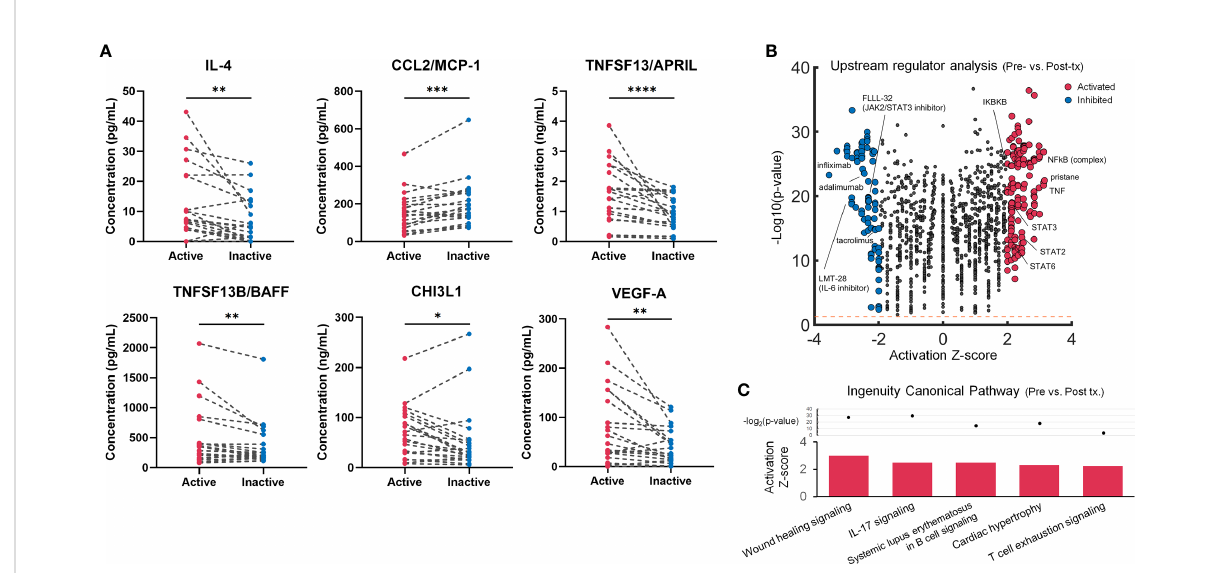
FIGURE 1 Multiplex blood cytokine/chemokine analysis results in the untreated and treated patients with large-vessel vasculitis (LVV). (A) Twenty-one blood samples from 21 patients with LVV in active or inactive state were examined using multiplex cytokines/chemokines analysis. A dot plot with a line shows individual cases. *p < 0.05, **p < 0.01, ***p < 0.001, ****p < 0.0001, Wilcoxon signed-rank test. (B) Volcano plot displaying signi fi cant regulators predicted by Ingenuity Pathway Analysis for untreated patients with LVV compared to post-treated patients. The y-axis corresponds to the value of -log 10 (p-value), and the x-axis displays the activation Z-score value. The red dots represent the predictably activated regulators or the blue dots inhibited. Positive x-values represent probable activation and negative probable inhibition. The Orange horizontal line denotes p-value of 0.05. (C) Ingenuity canonical pathways with the prediction of its activated pathway in pre-treated vs. post- treated patients with